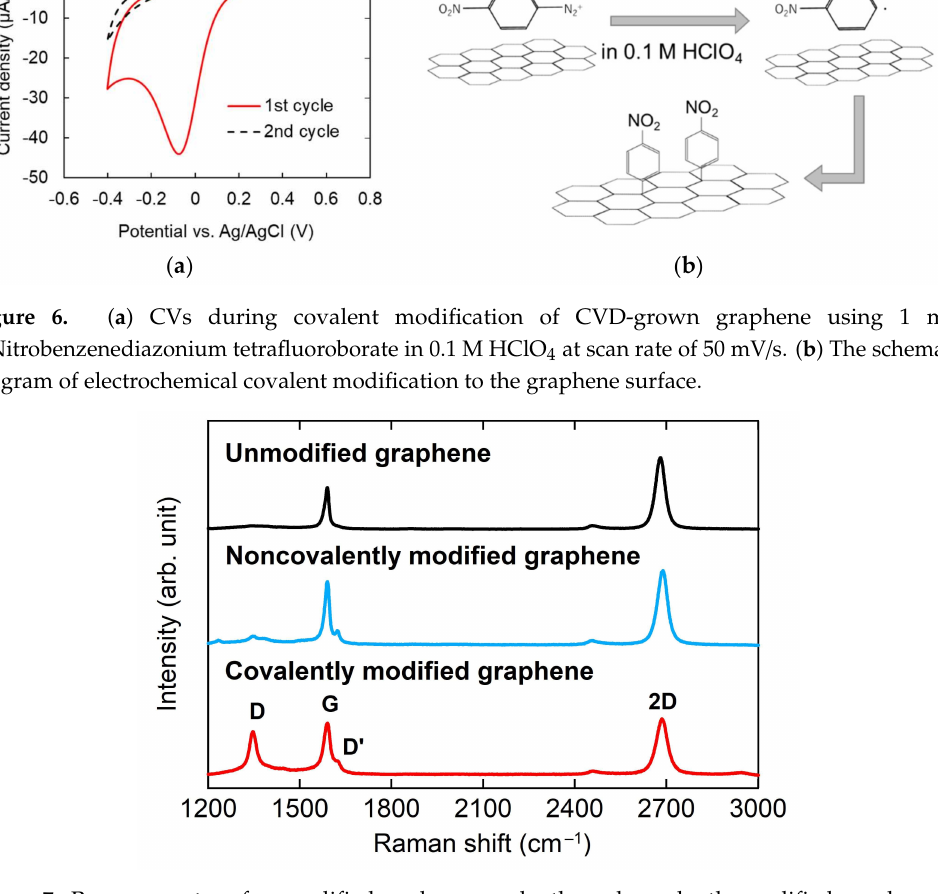
Figure 7. Raman spectra of unmodified, and noncovalently and covalently modified graphene on SiO 2 / Si